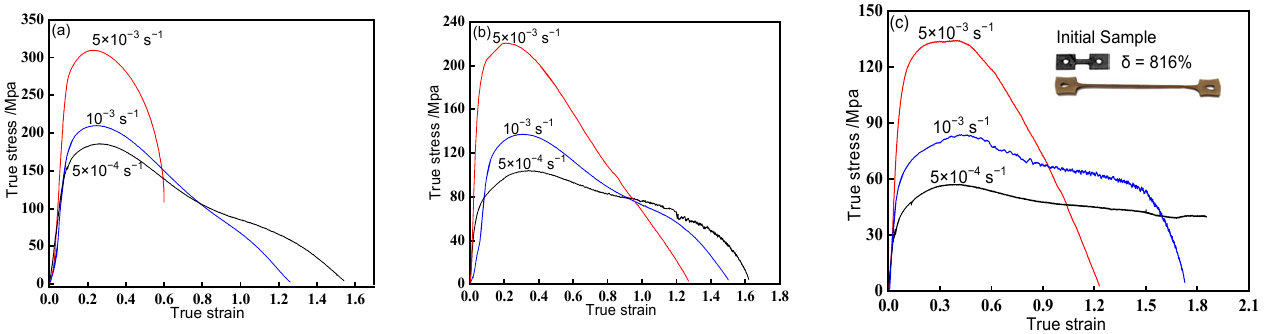
Figure 2. True stress–strain curves of the Ti-6Al-4V alloy during superplastic tension at different conditions: ( a ) 750 °C, ( b ) 780 °C, ( c ) 810 °C, and representative macrographs of the specimens before conditions: ( a ) 750 ◦ C, ( b ) 780 ◦ C, ( c ) 810 ◦ C, and representative macrographs of the specimens before and after tensile deformation (inset). and after tensile deformation